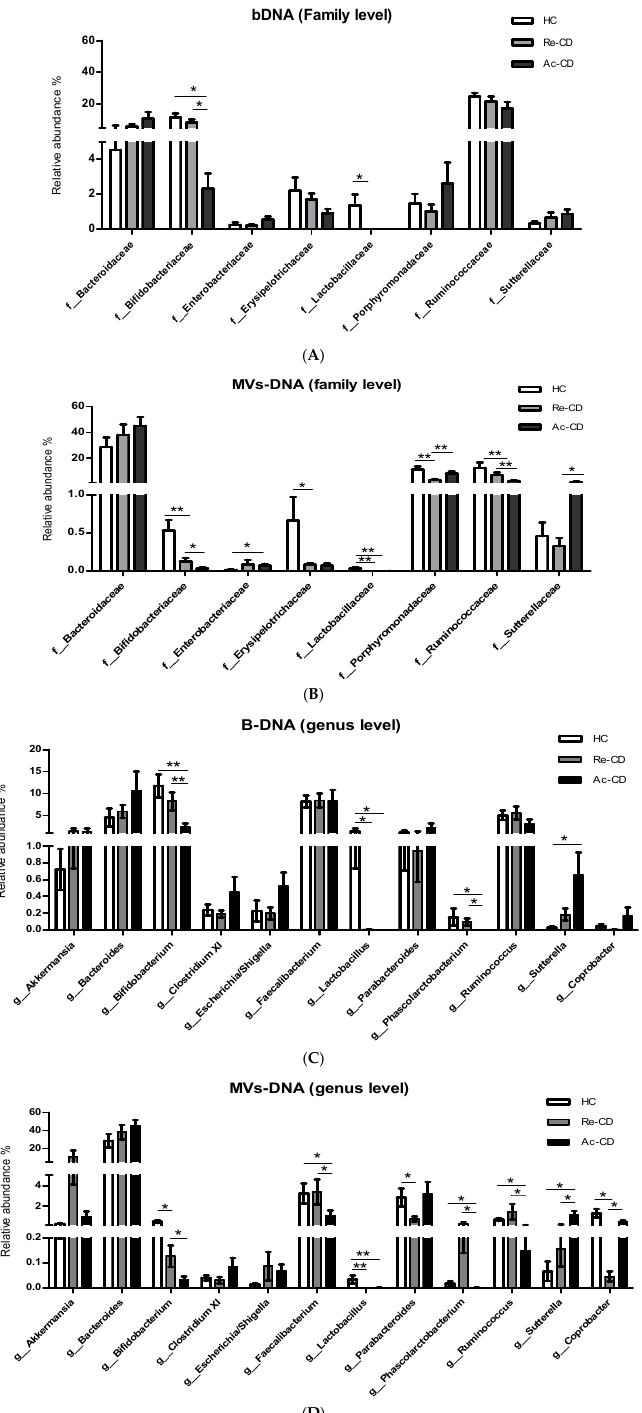
Figure 5. Relative abundance of microbial compositions of MV-DNA and bDNA at the family and genus levels. ( A , C ) The relative abundances of the most important families and genera that show clinical importance in IBD, in DNA obtained from bacterial fractions. ( B , D ) Relative abundances of microbial compositions of DNA derived from MV fractions. Results represented as means ± SEM. A Mann–Whitney test was used for statistics; p -value indicated as (* < 0.05, ** < 0.01).